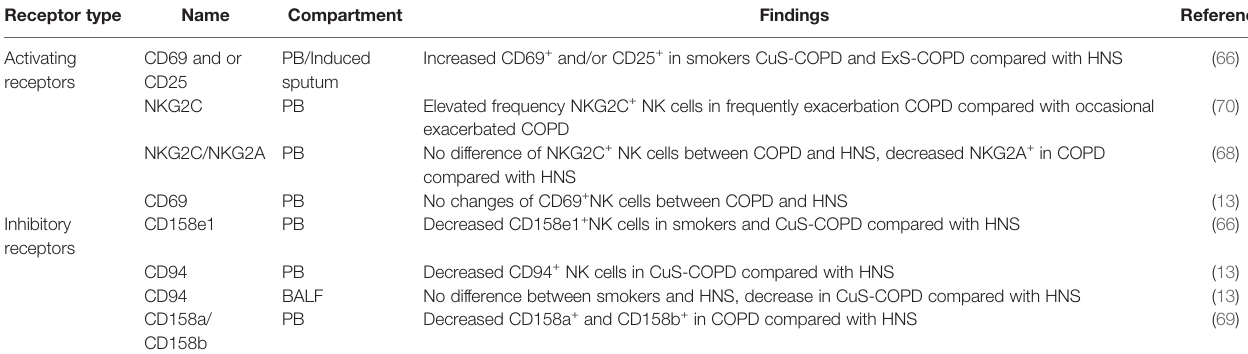
TABLE 2 | Activating and inhibitory receptors in COPD of human.